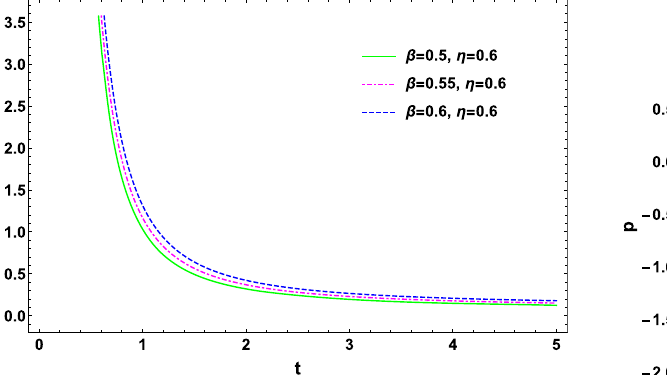
Fig. 3 Variation of energy density against z with α = 0 . 2, μ = − 1, λ = − 8